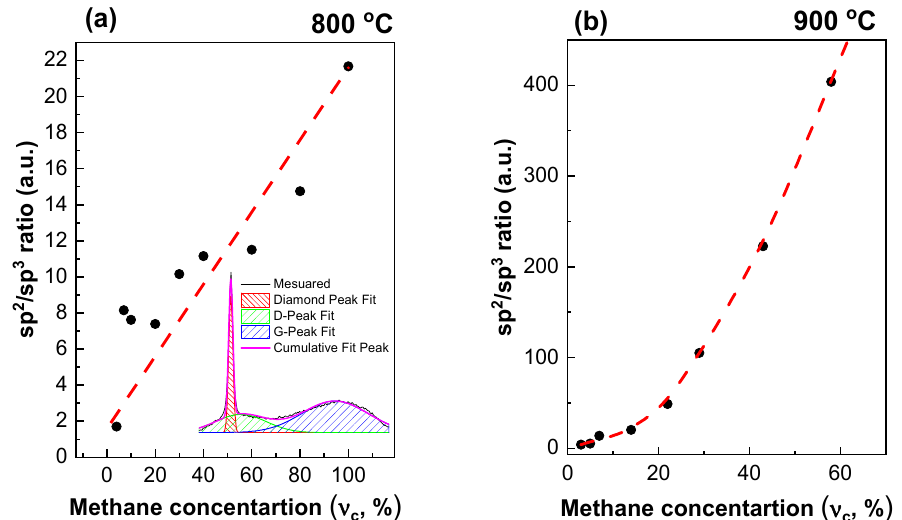
Figure 6. The sp 2 /sp 3 ratio for diamond films grown at substrate temperatures 800 °C ( a ) and 900 °C ( b ) depending on the methane concentration. The lines are guides for the eye. Insert: a typical example of Raman spectra deconvolution into the components (for sample ν c = 5% and T s = 900 °C).